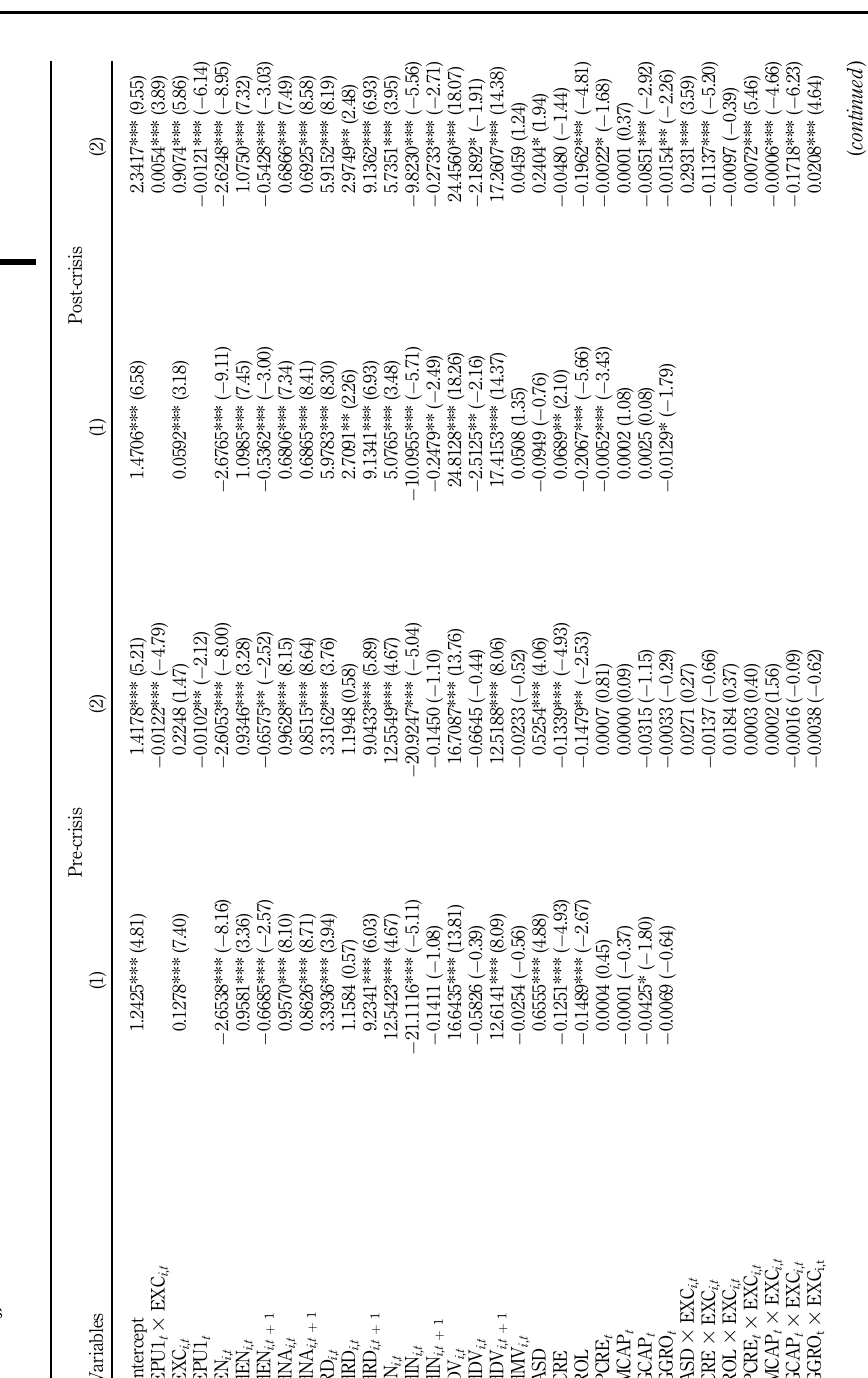
Table 3. Robustness checks with the reduced